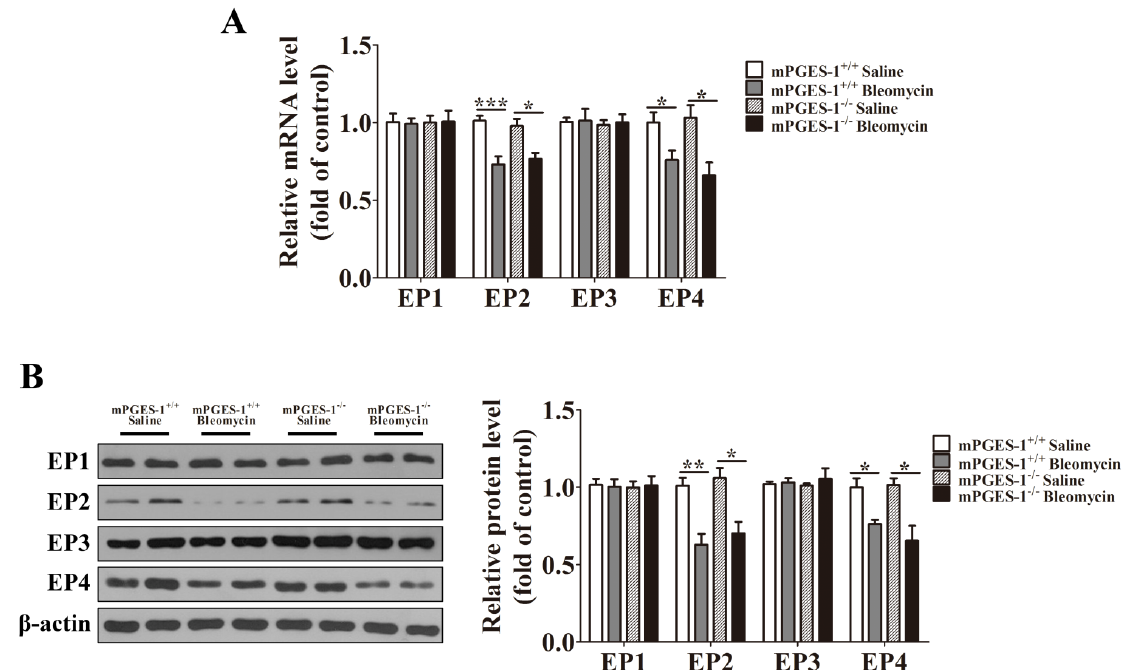
receptor subtypes in the lungs of mPGES-1 +/+ mice and Figure 3. The expression of PGE 2 mPGES-1 − / − mice receiving bleomycin or saline. ( A ) Statistical chart of mRNA expression; ( B ) Representative western blot images and scanning densitometry of protein expression. Results are expressed as means ± SEM ( n = 4–6 mice per group) ( * p < 0.05, ** p < 0.01, *** p <